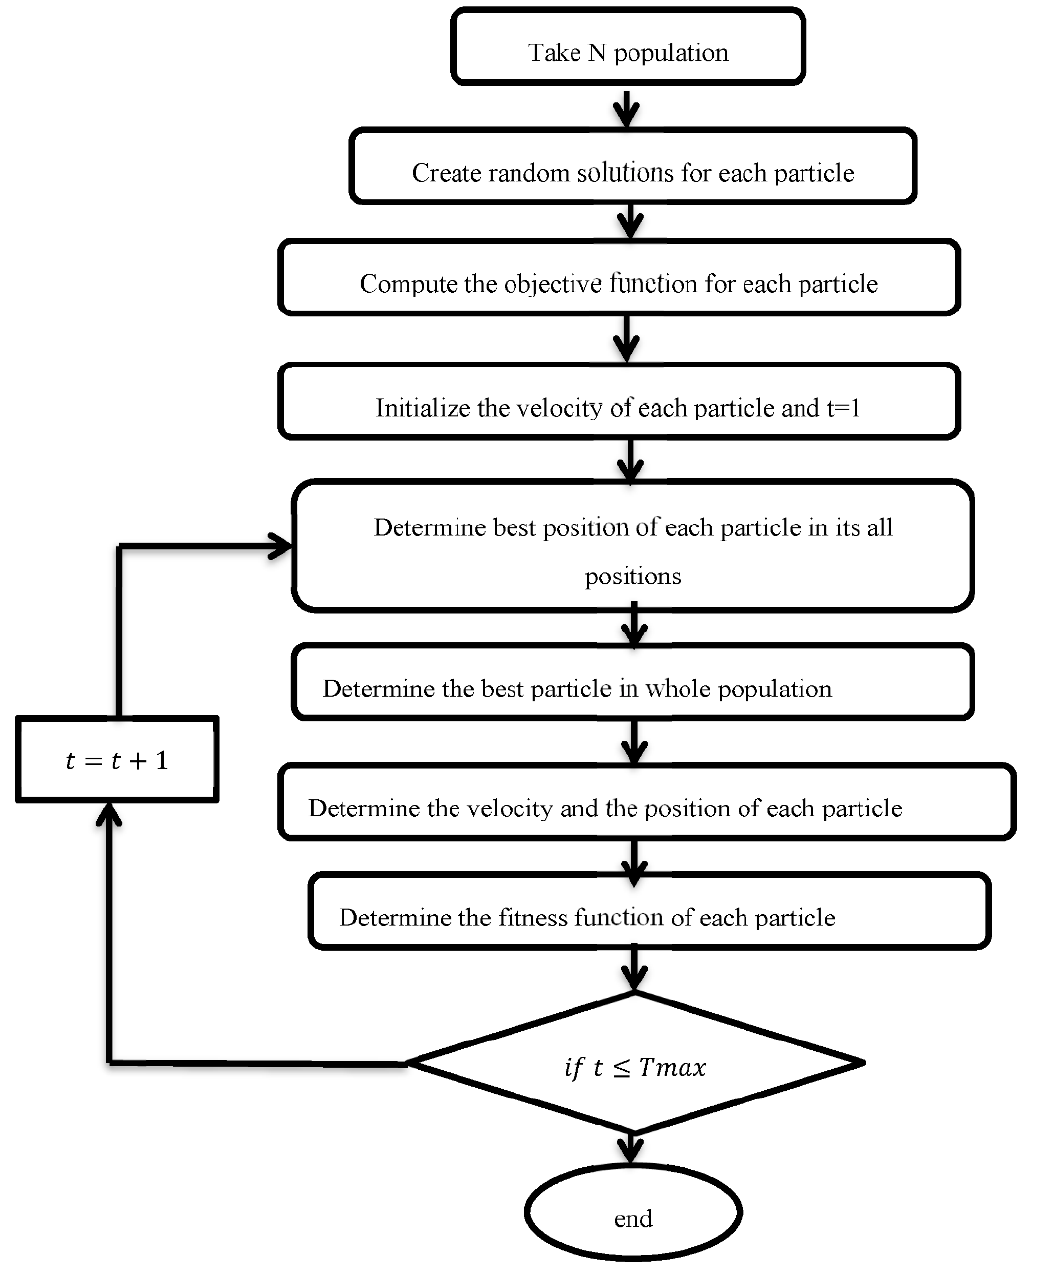
Figure 3. Flow chart of PSO algorithm.